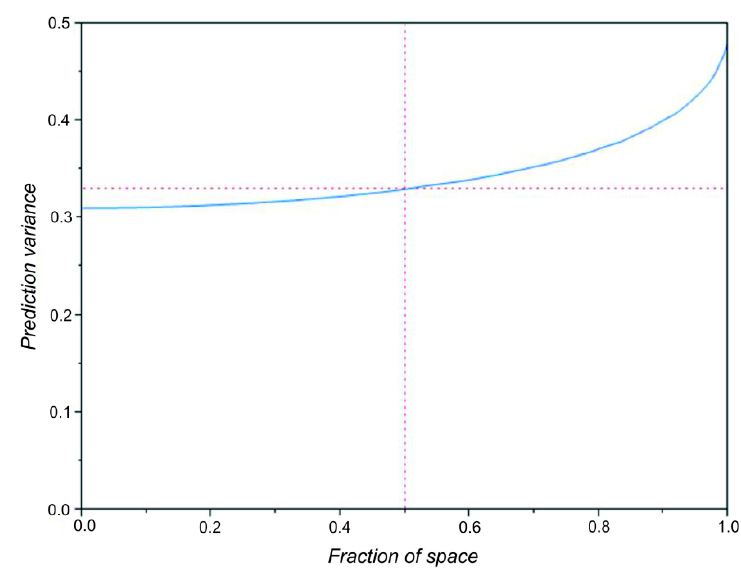
Figure 5. Diagram of design space.